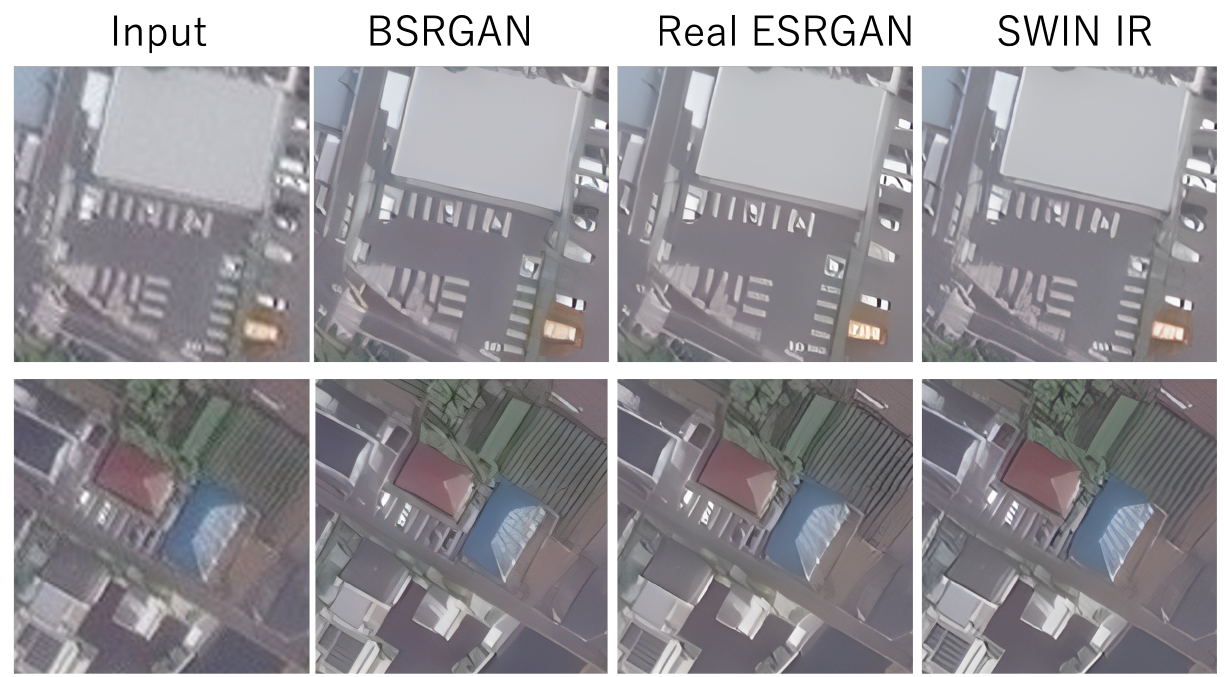
Figure 3. The typical case of real-world super-resolution results at scale factor 4. From left to right: input image, BSRGAN (Zhang et al., 2021), Real ESRGAN (Wang et al., 2021a), SWIN IR (Liang et al., 2021). The images are obtained WorldView-2 sensor from MAXAR.